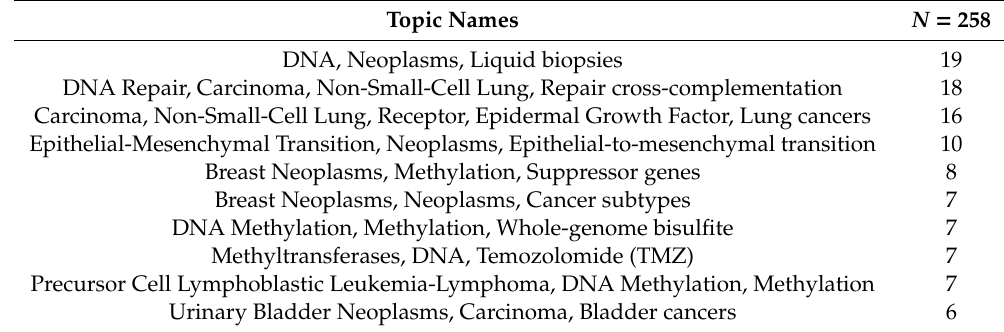
Table 8. DNA Repair. Cluster (11), weigh